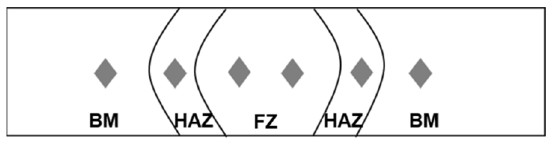
Figure 2. Vickers hardness profile used.